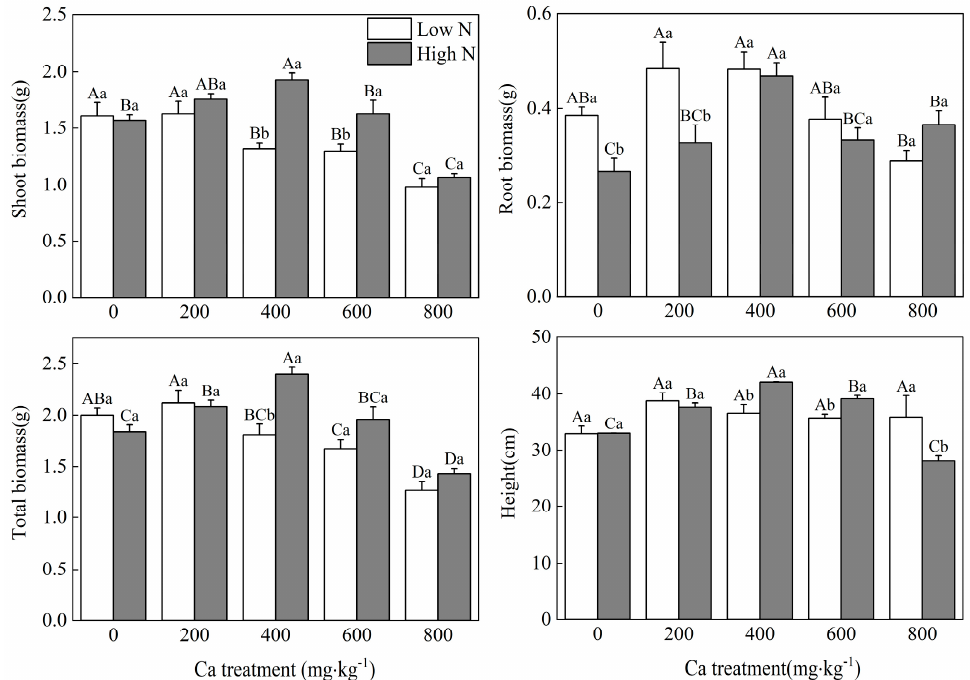
Figure 2. Effect of Ca treatments on the growth of mulberry seedlings under different N levels. Capital letters denote significant differences among different Ca treatments within the same N level. Lowercase letters denote significant differences between the different N levels within the same Ca treatment.